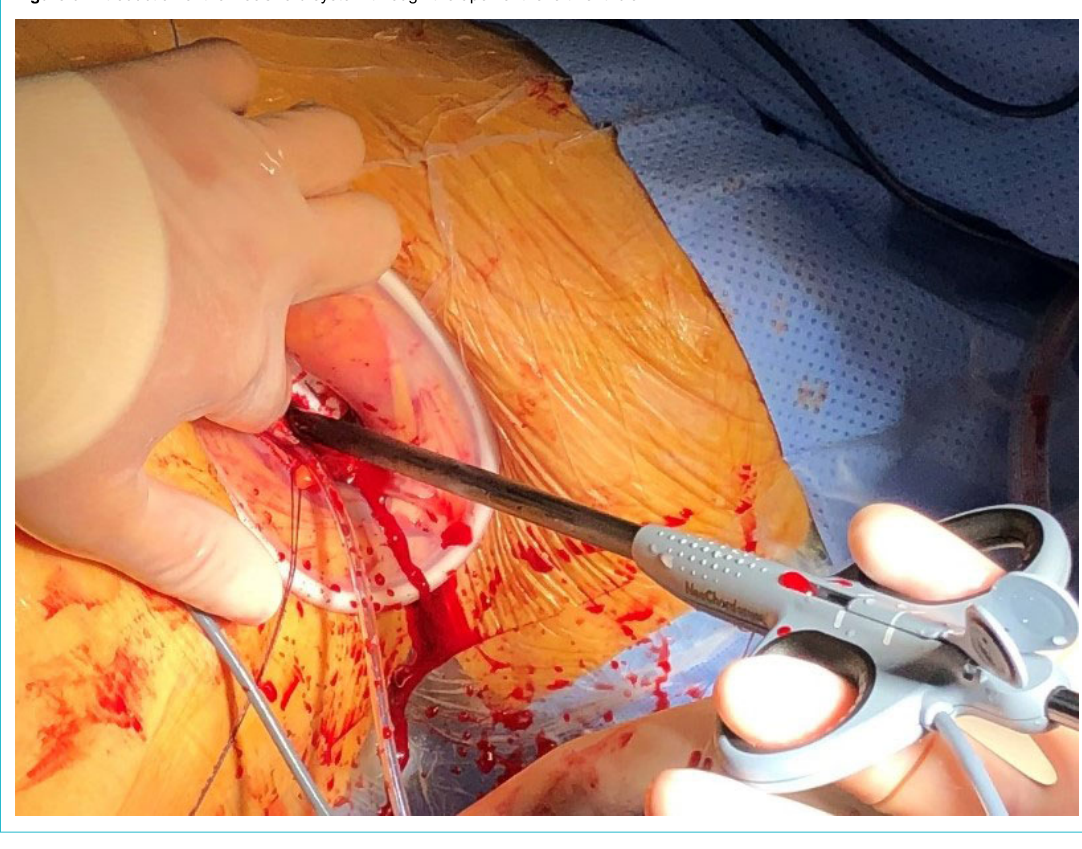
Figure 3: Introduction of the NeoChord system through the apex of the left ventricle.